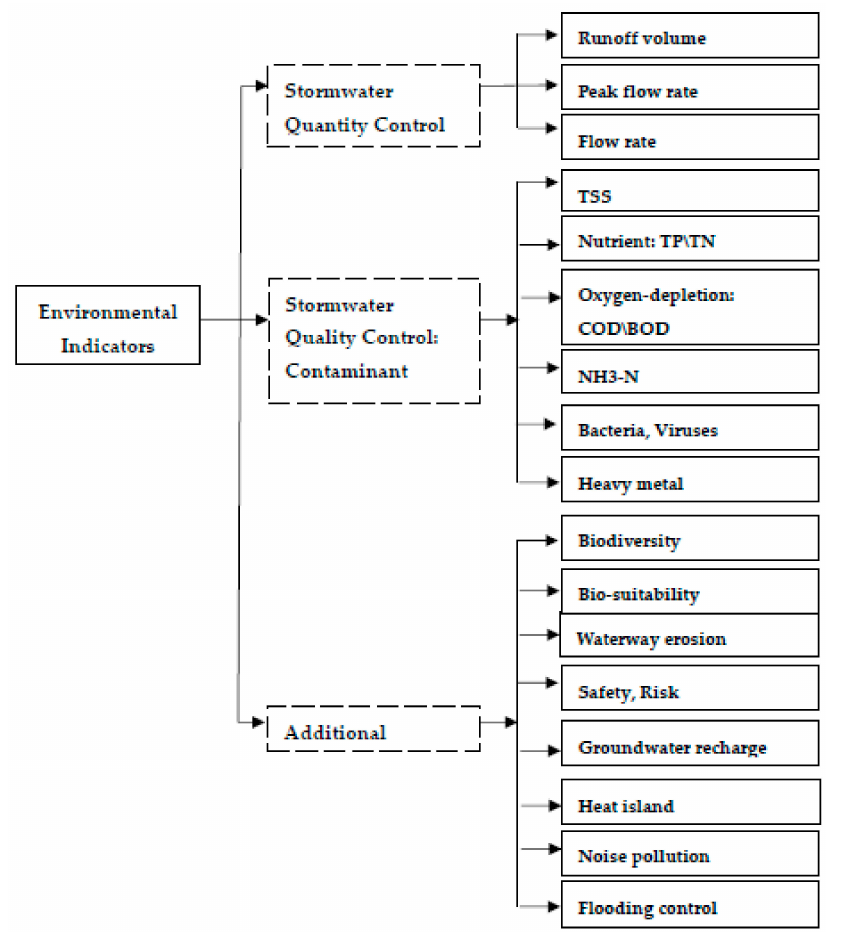
Figure 2. Environmental